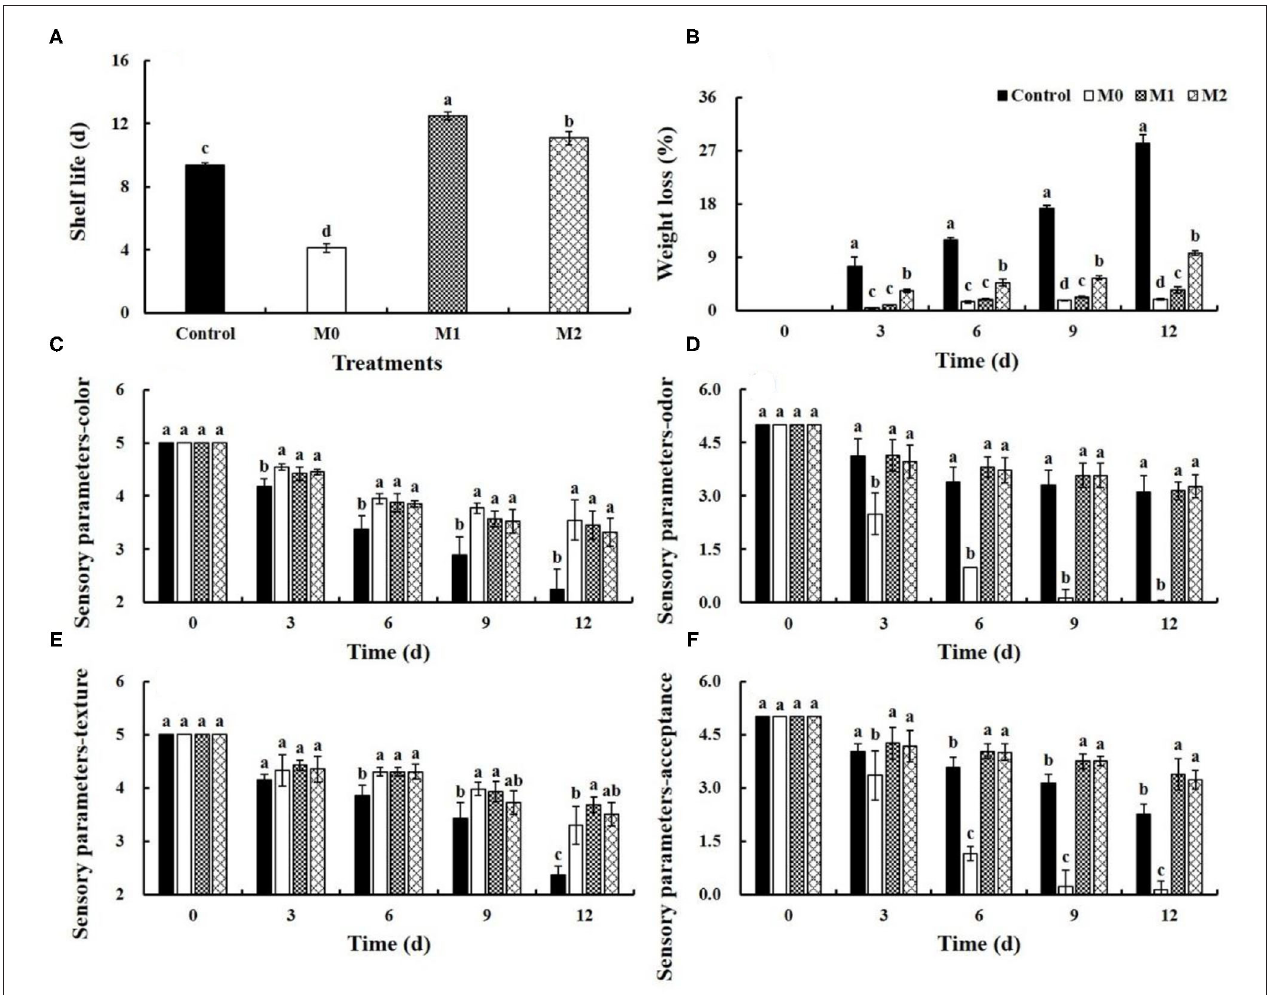
FIGURE 2 | Shelf life (A) , weight loss (B) , and sensory parameters (C–F) of different baby mustard lateral buds during storage at 4 ◦ C under different MAP treatments. Sensory parameters include color, odor, texture, and acceptance of lateral buds. Different letters in (A) indicate statistically significant differences among treatments ( P < 0.05), and different letters in (B–F) indicate statistically significant differences among treatments for each storage day ( P < 0.05). M0 indicates packaging with no holes; M1 indicates packaging with 6mm in diameter holes; M2 indicates packaging with 12mm in diameter